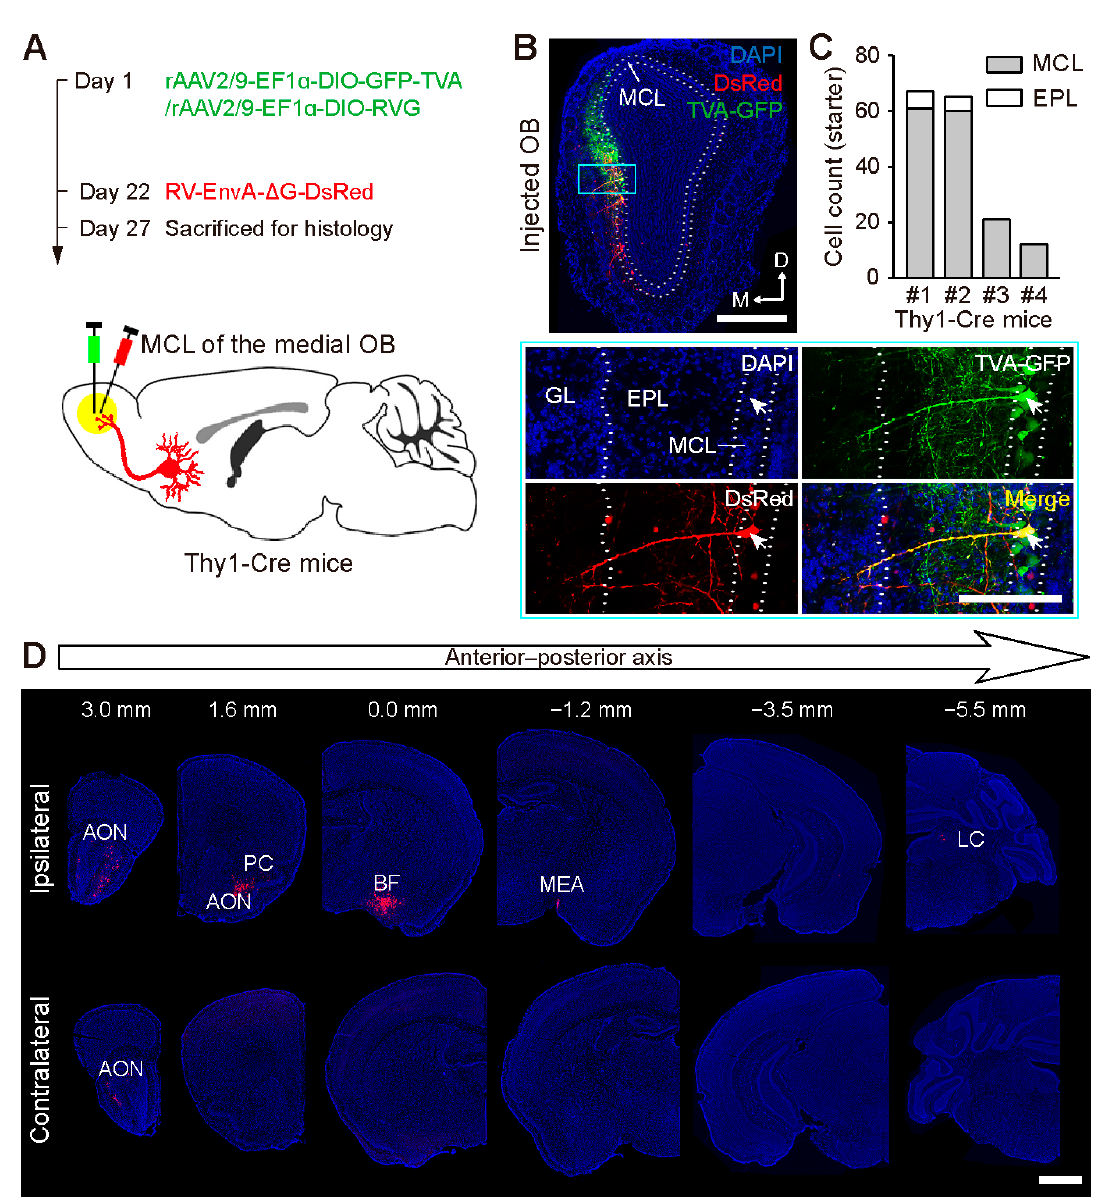
Figure 1 . Retrograde tracing of the monosynaptic input to the M/TCs of the medial OB. ( A ) Strategy for tracing the input from the M/TCs using RV-based retrograde monosynaptic tracing viruses. ( B ) Upper: Representative image showing starter neurons in the MCL of the medial OB. Lower: Magnification of the blue outlined area in the upper image. The arrowhead indicates a starter neuron in the MCL co-expressing TVA-GFP and RV-DsRed. MCL, mitral cell layer; EPL, external plexiform layer; GL, glomerular layer. ( C ) Cell count of starter neurons in each mouse. ( D ) Examples of images showing fluorescently labeled input neurons in the major brain areas. AON, anterior olfactory nucleus; PC, piriform cortex; BF, basal forebrain; MEA, medial amygdalar nucleus; LC, locus coeruleus. Scale bars, 500 µ m in ( B ) (upper); 200 µ m in ( B ) (lower); 1 mm in ( D ).